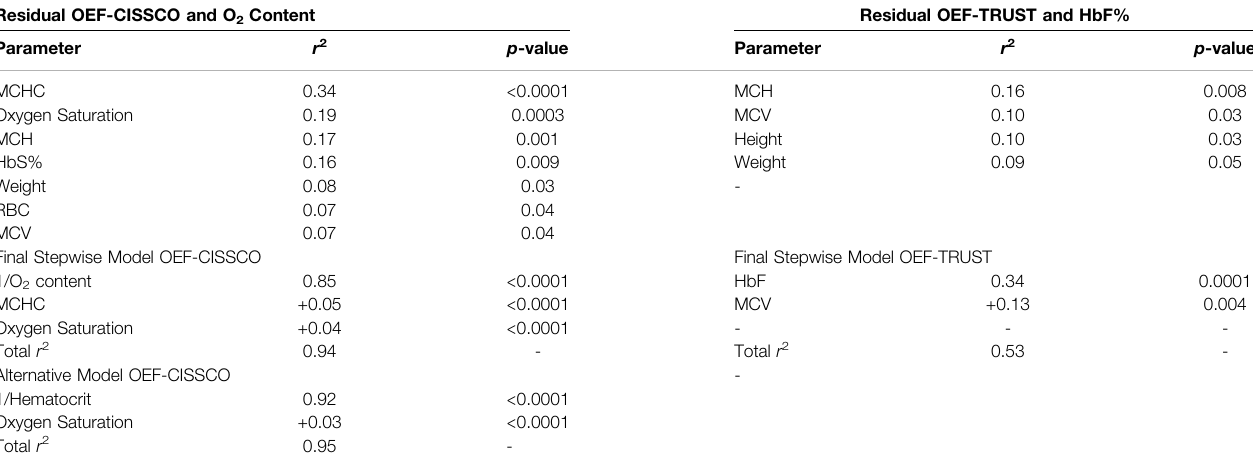
TABLE 3 | OEF predictors by stepwise